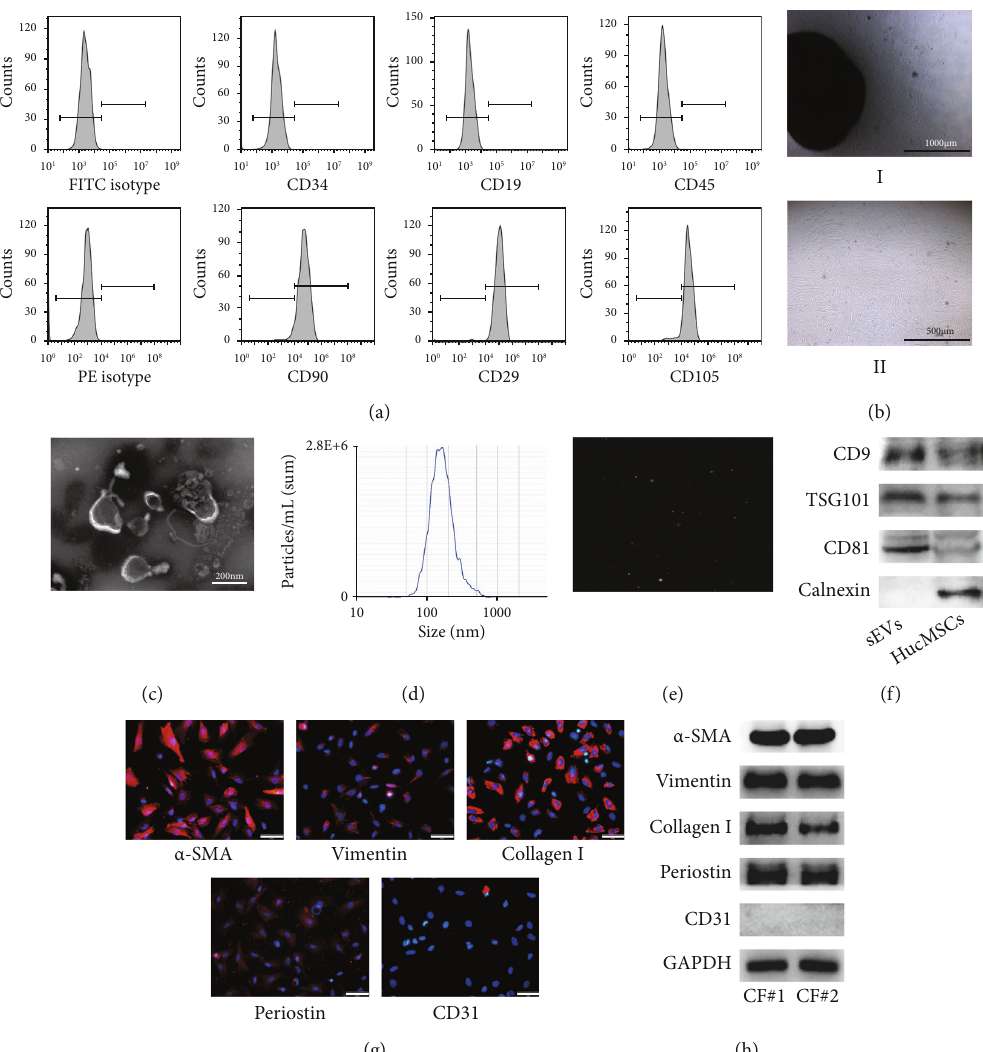
Figure 1: Characterization of hucMSCs, sEVs, and CFs. (a) The surface markers of hucMSCs measured by fl ow cytometry. (b) Morphology of hucMSCs. Scale bar: 1000 μ m (i) and 500 μ m (ii). (c) Morphology of sEVs observed by TEM. Scale bar: 200nm. (d) Particle size distribution of sEVs measured by NTA. (e) Brownian motion image of hucMSCs. (f) Protein expression of CD9, TSG101, CD81, and calnexin in hucMSCs and sEVs. (g, h) The expression of α -SMA, vimentin, collagen I, periostin, and CD31 on primary CFs was measured by immuno fl uorescence (g) and western blotting (h). Scale bar: 50 μ